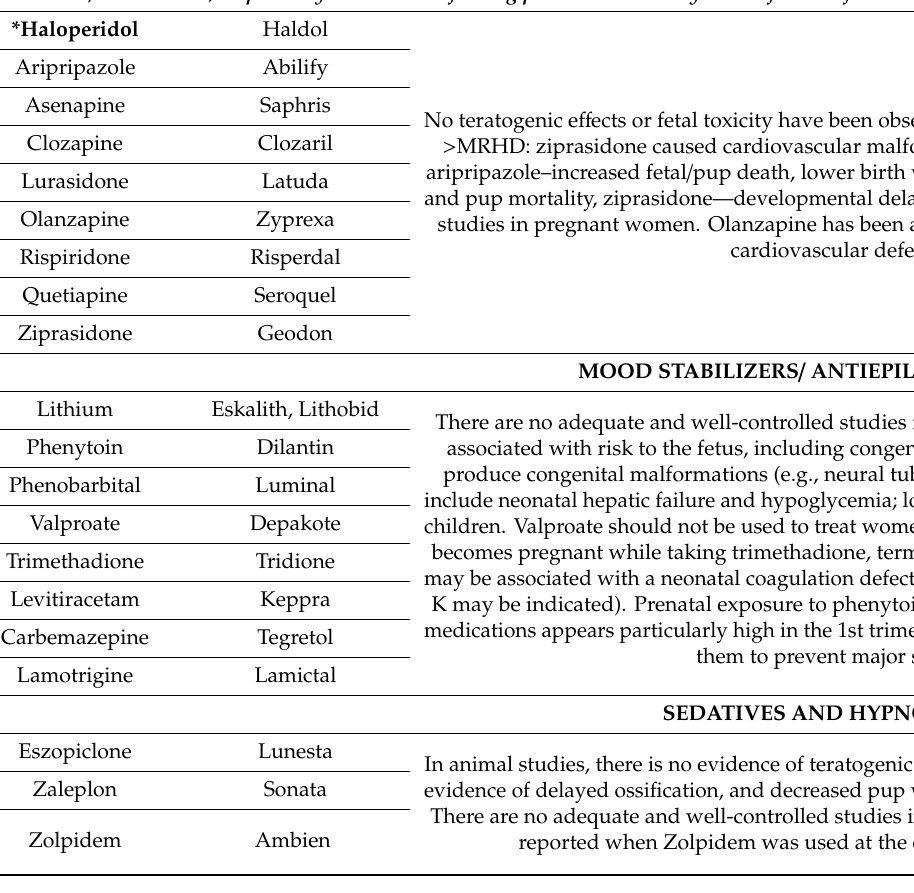
Table 4. Drugs approved by the FDA to treat bipolar and psychiatric disorders according to drug class and trade name used in the U.S., along with a summary of label